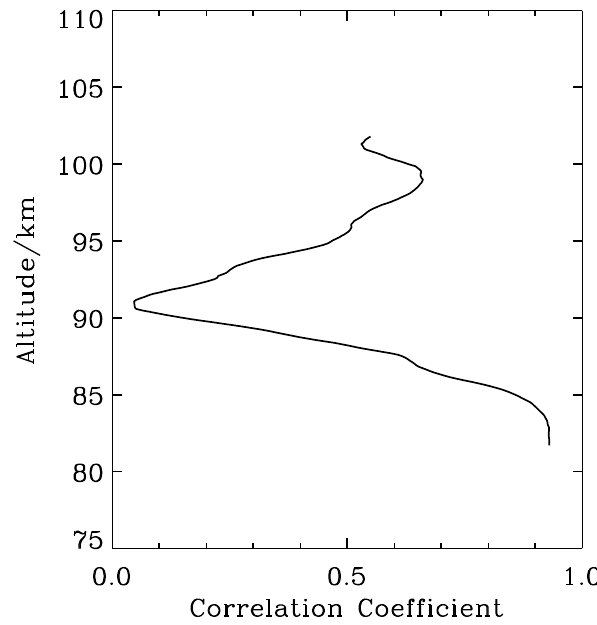
Fig. 11. Mean correlation coefficient between simultaneously-observed Na and Fe densities versus altitude derived from all the 47 nights. The correlation coefficient is smoothed with running mean over 1.4 km.